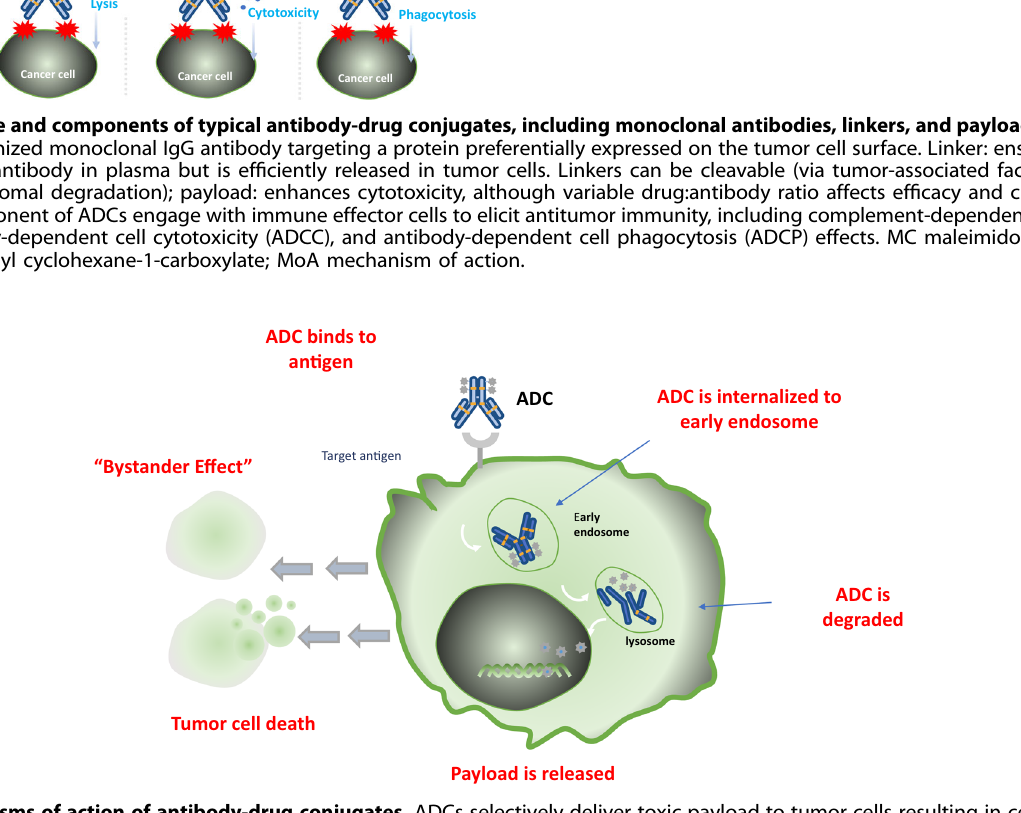
Fig. 2 Mechanisms of action of antibody-drug conjugates. ADCs selectively deliver toxic payload to tumor cells resulting in cell death. The “ bystander effect ” of ADCs alter stumor microenvironment to enhance cell